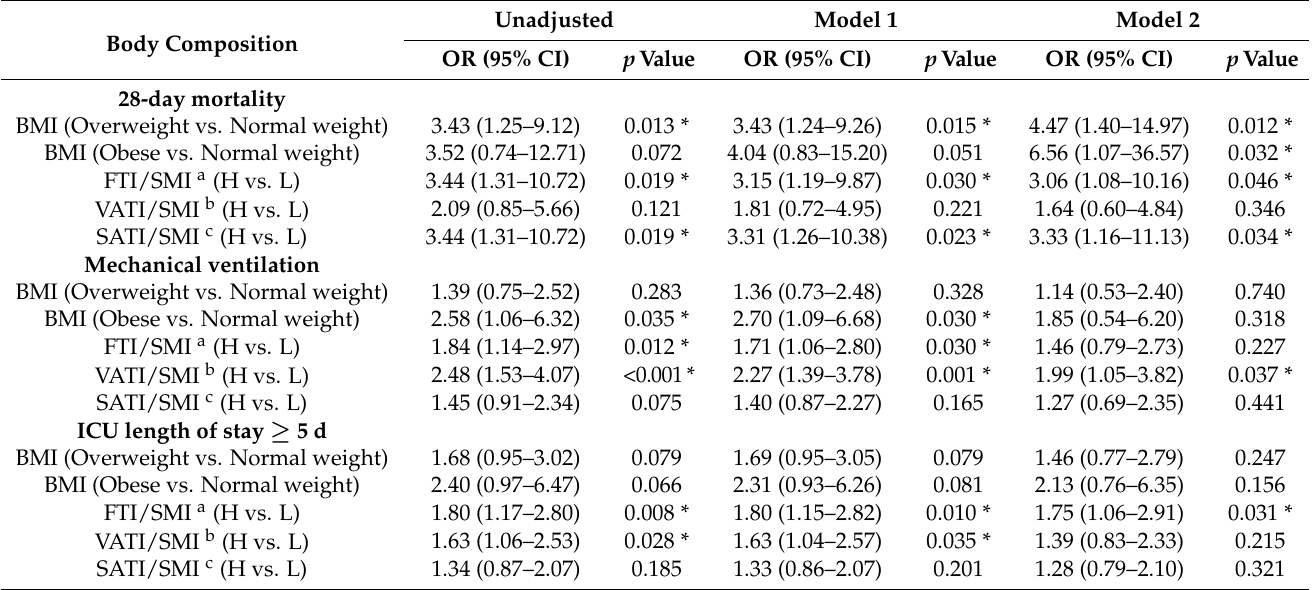
Table 2. Associations between different body composition indices and 28-day mortality, mechanical ventilation, and ICU length of stay ≥ 5 d in patients with abdominal trauma.